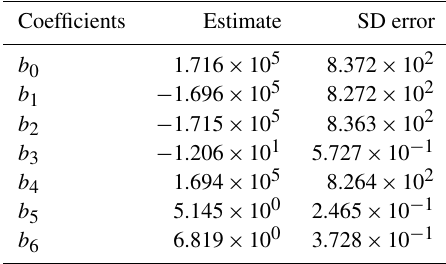
Table A2. The coefficient values of Eq. (1) and errors (SD) for the NR